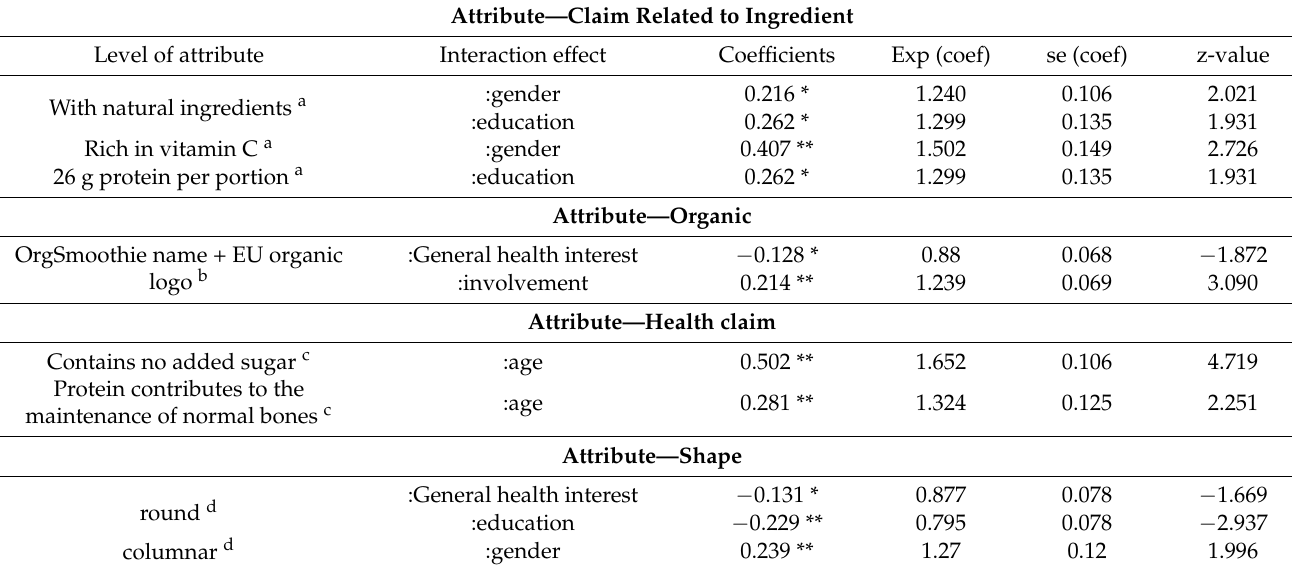
Table 3. Results of the conditional logit model: Interaction